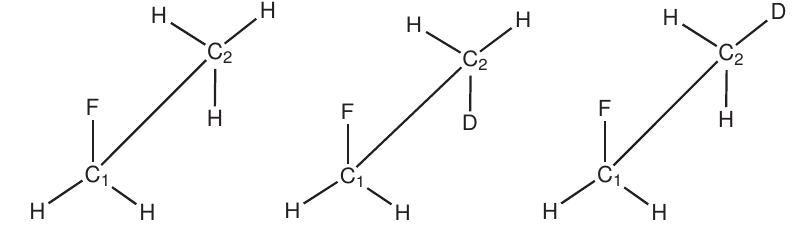
Figure 1. Fluoroethane without deuterium label ( left ), with deuterium in antiperiplanar conformation ( center ) and with deuterium in gauche conformation ( right ) with respect to the fluorine